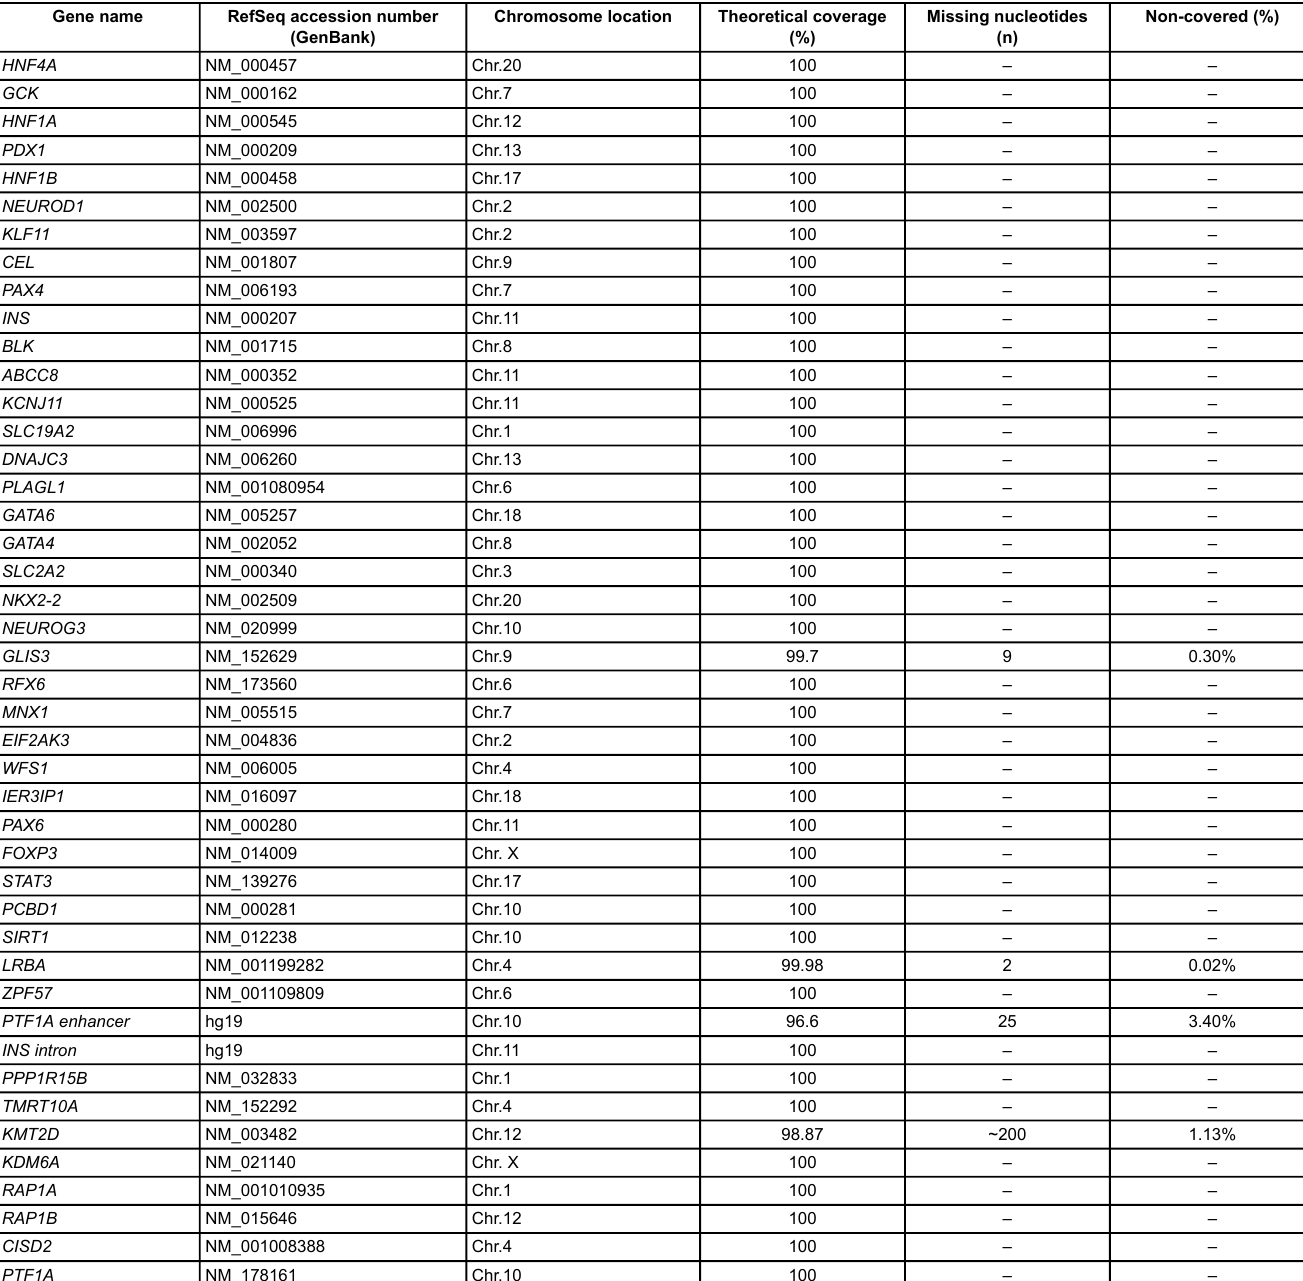
Table 4: Gene panel for the diagnosis of monogenic diabetes. Gene